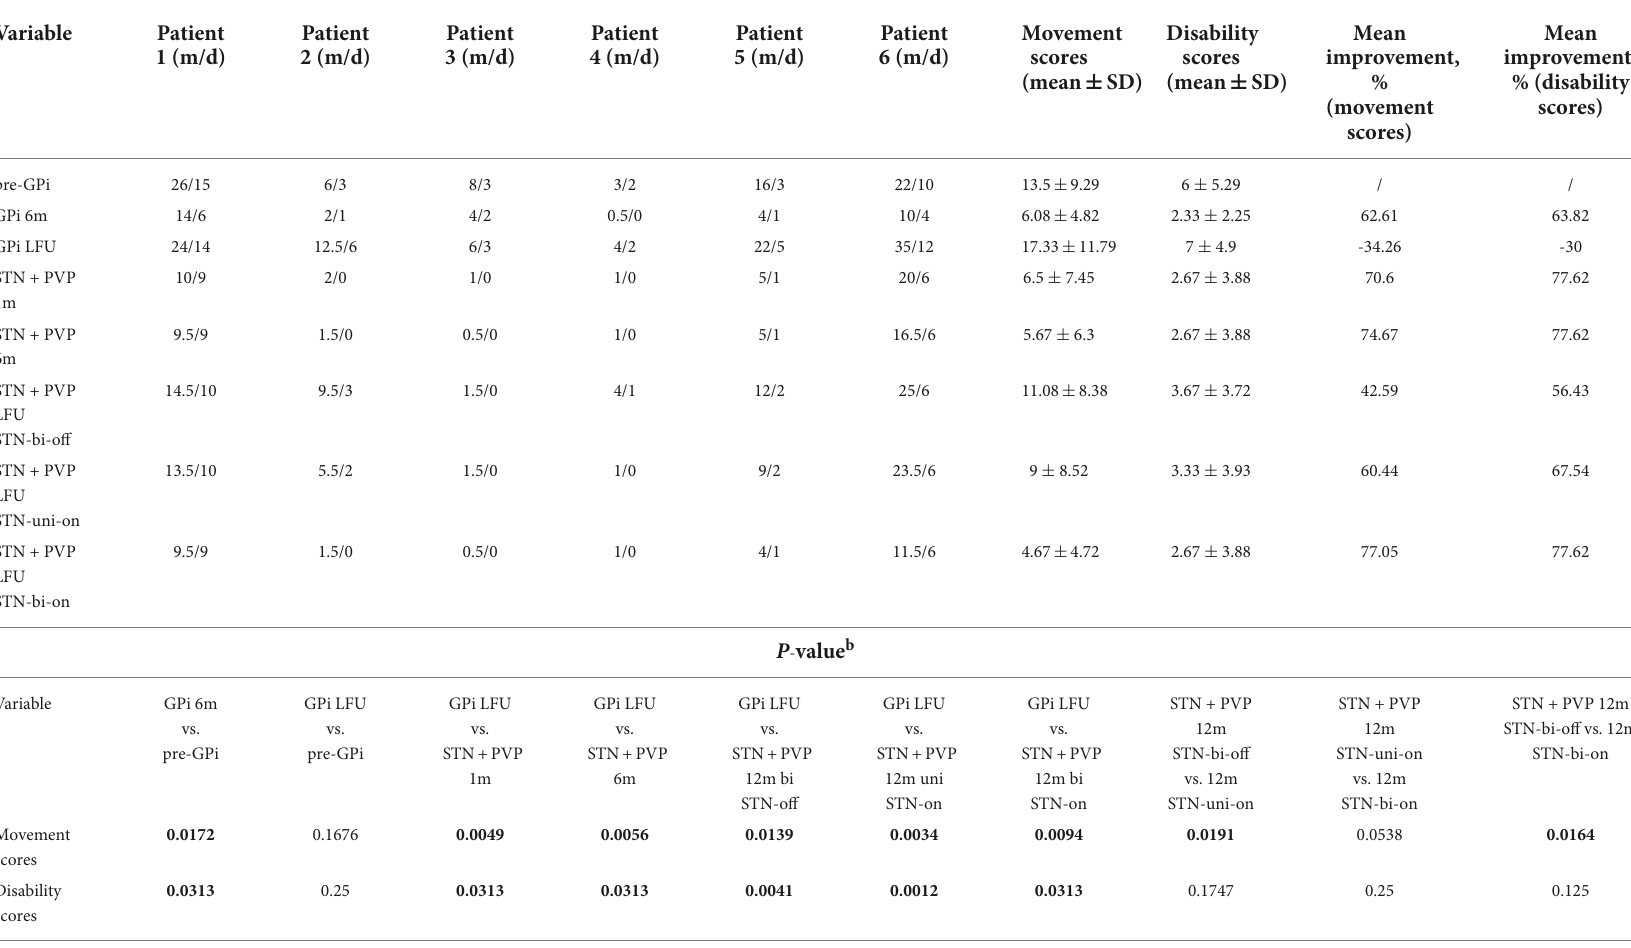
TABLE 2 Effect of treatment on BFMDRS movement and disability scales after surgery.